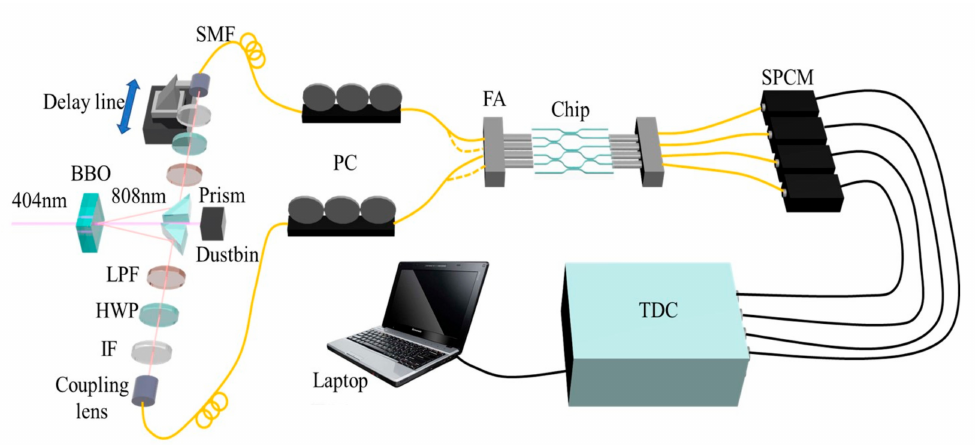
Figure 4. Experimental setup for quantum characterization. Through Type-I spontaneous parametric down-conversion (SPDC) process, 808 nm photon pairs are generated by pumping the BBO crystal using 140 mW, 404 nm CW diode laser. Long pass filter (LPF) from 650 nm and interference filter (IF) at 808 nm with 3 nm bandwidth are used to ensure spectral indistinguishability. Half-wave plate (HWP) and polarization controller (PC) are used to control the polarization state of photons in fiber. A delay line is inserted into one way to control the relative arrival time of photons to ensure temporal indistinguishability. Photons are injected into waveguides in the chip through fiber array and then collected at the output by another fiber array. Single photon counting modules (SPCMs) and the Time to Digital Converter (TDC) are used to conduct coincidence counting of di ff erent output-photon